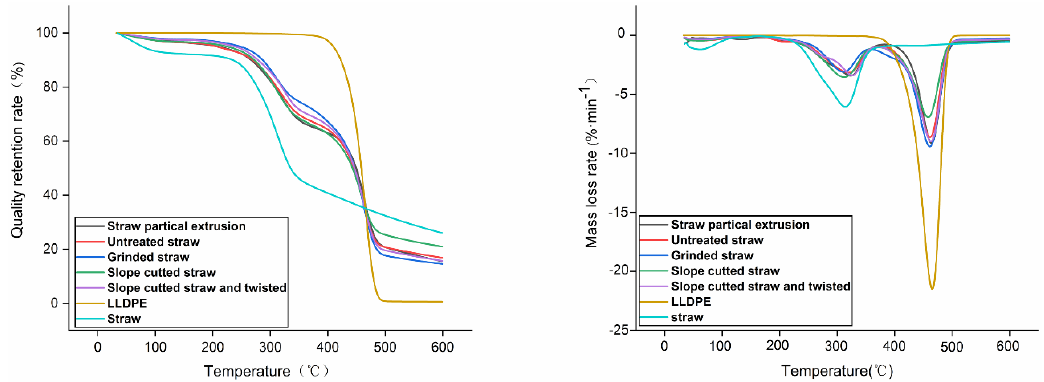
Figure 8. TG curve of straw, LLDPE, and straw/LLDPE composite.